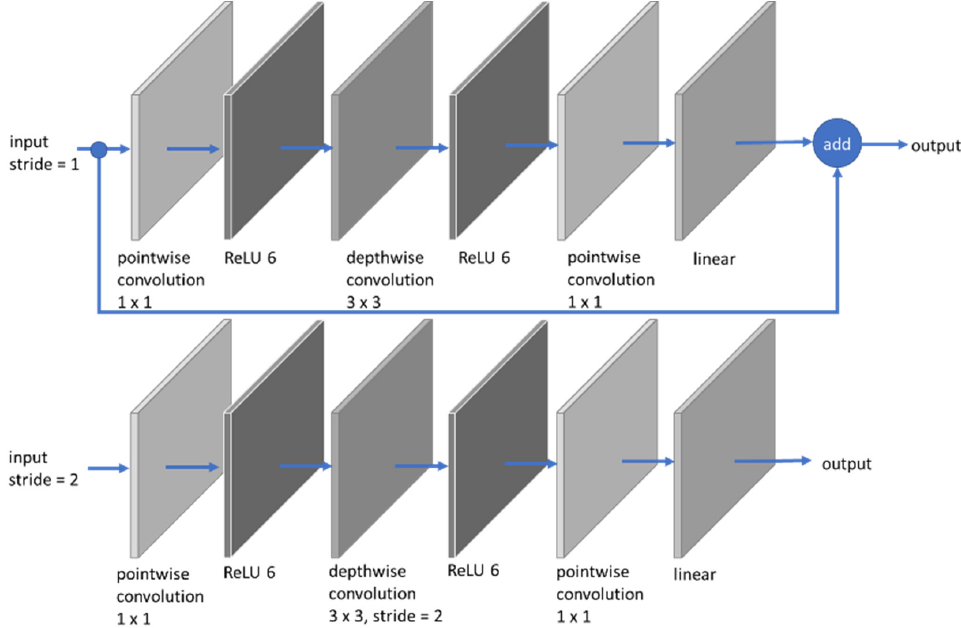
Figure 4. MobileNet-V2 building block architecture of this